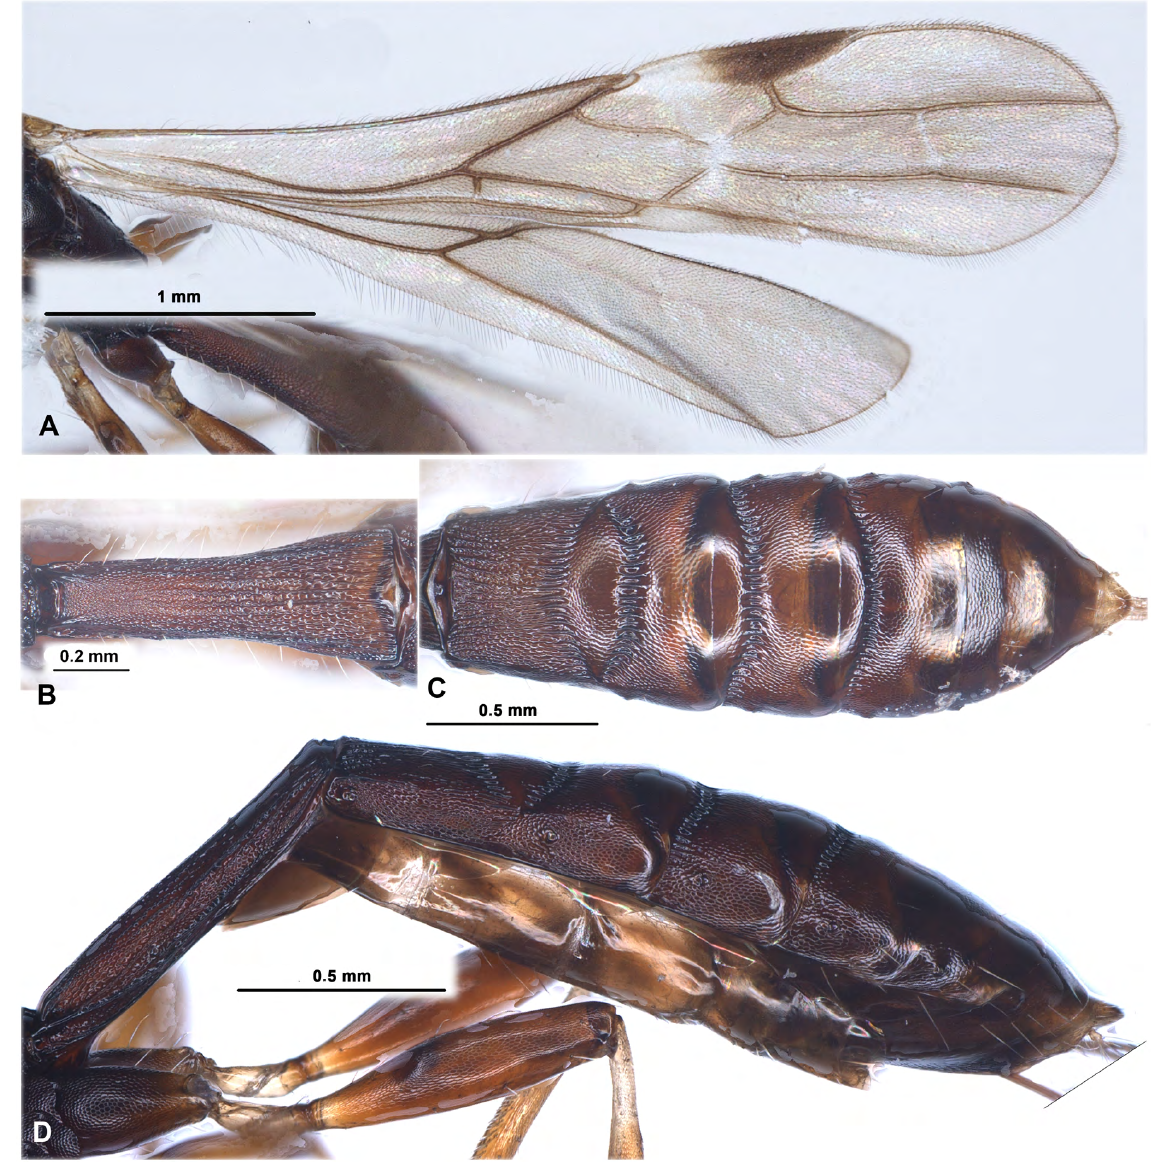
Fig. 35. Platyspathius ( Platyspathius ) ranomafanus sp. nov. ♀, holotype, ZISP. A . Wings. B . First metasomal tergite, dorsal view., C . Metasoma without first tergite, dorsal view. D . Metasoma, lateral